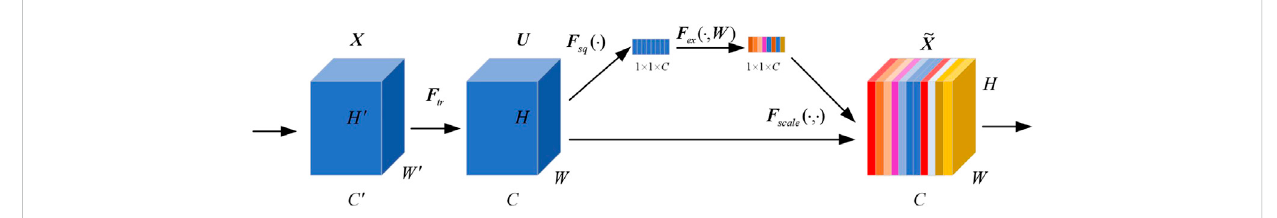
FIGURE 2 The SE building block.